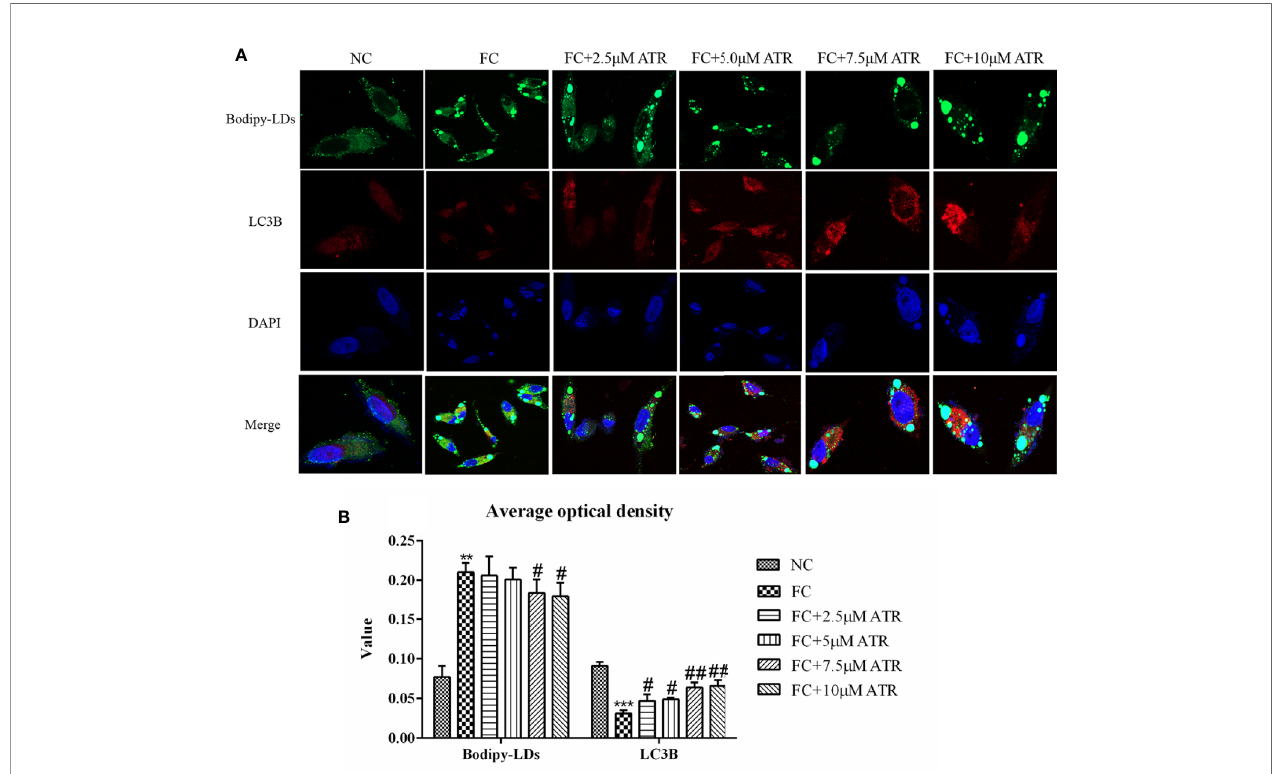
FIGURE 6 | ATR treatment promoted LC3 protein expression in LDs. (A) Representative confocal images of co-localization of DyLight 680-stained LC3B protein with BODIPY-stained LDs. Scale bars: 10 m m. (B) Optical density analysis of fl uorescence intensity. Data are expressed as mean ± SD (n=3). **P<0.01, ***P<0.001 (* represents the FC group compared with the NC group). # P<0.05, ## P<0.01 ( # represents FC+ATR treatments compared with the FC group). NC=normal group, and FC=FFA